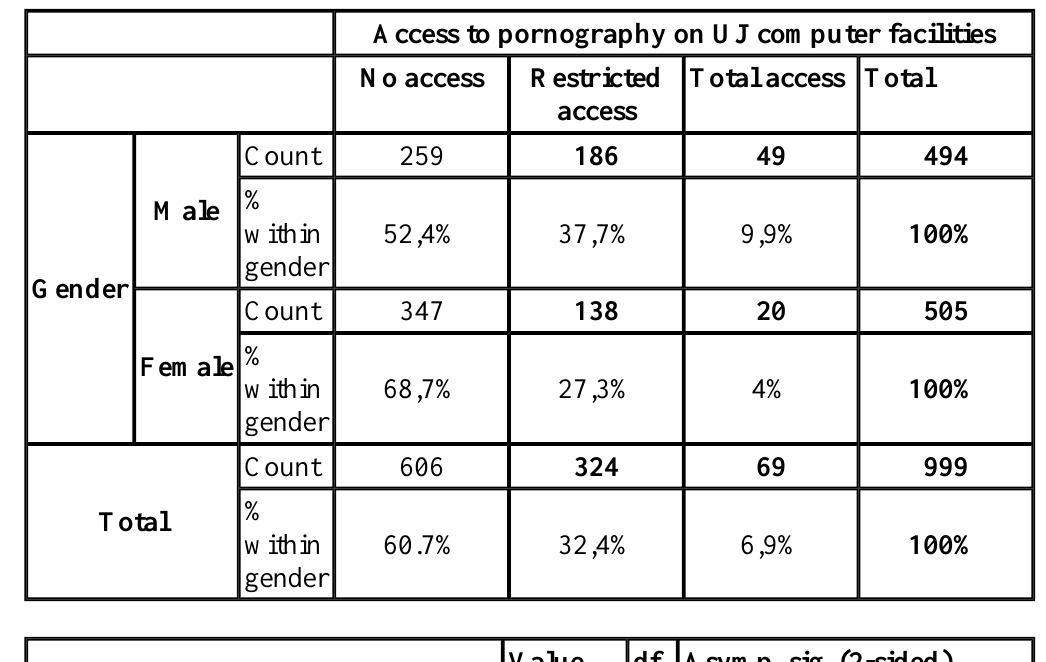
Table 5 Cross tabulation of gender differences for Question 14 (access to pornography on the UJ computer